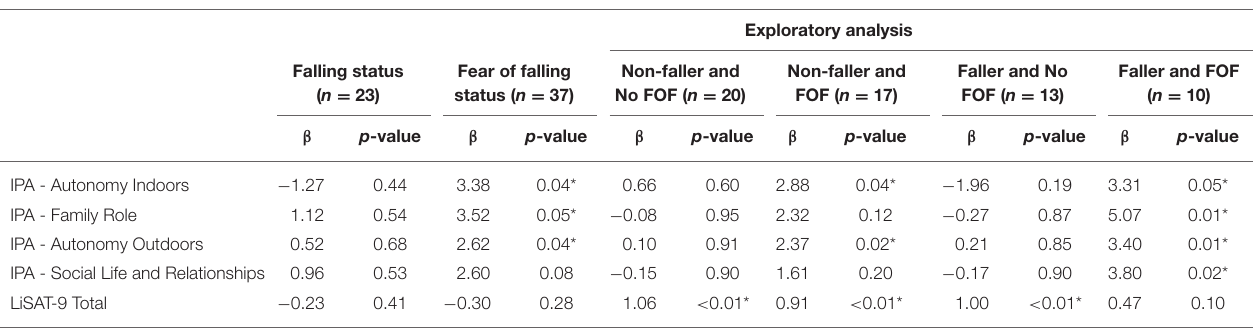
TABLE 3 | Ordinary least squares